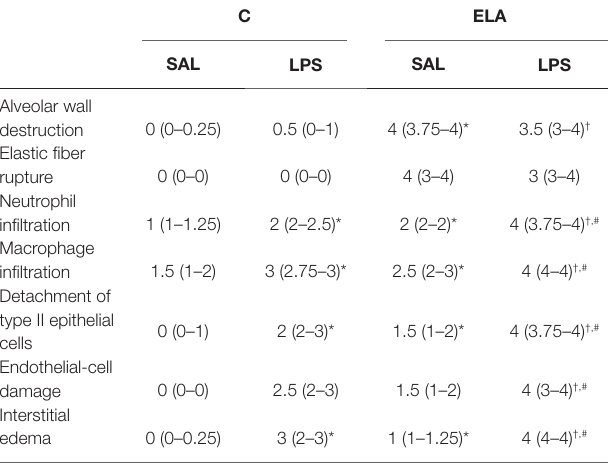
TABLE 3 | Semiquantitative analysis of lung electron